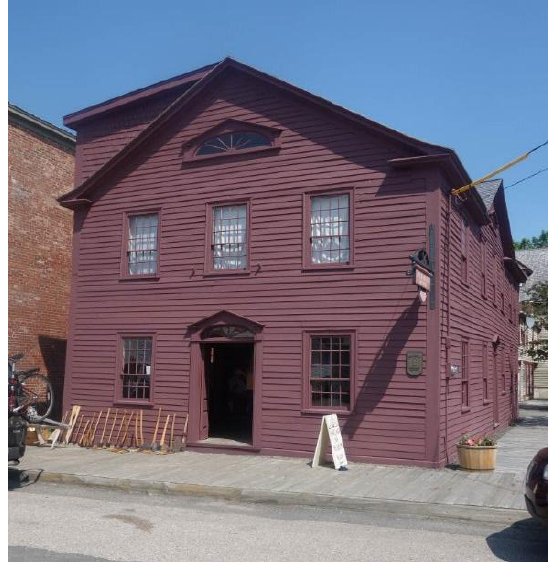
Figure 1: Sinclair Inn Museum, Main entrance façade, Lower George Street, June 2015. Source: